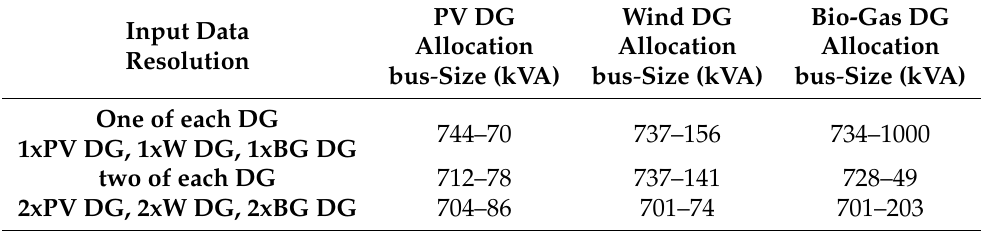
Table 14. Optimal allocation of DGs in the IEEE 37 Node Test Feeder.